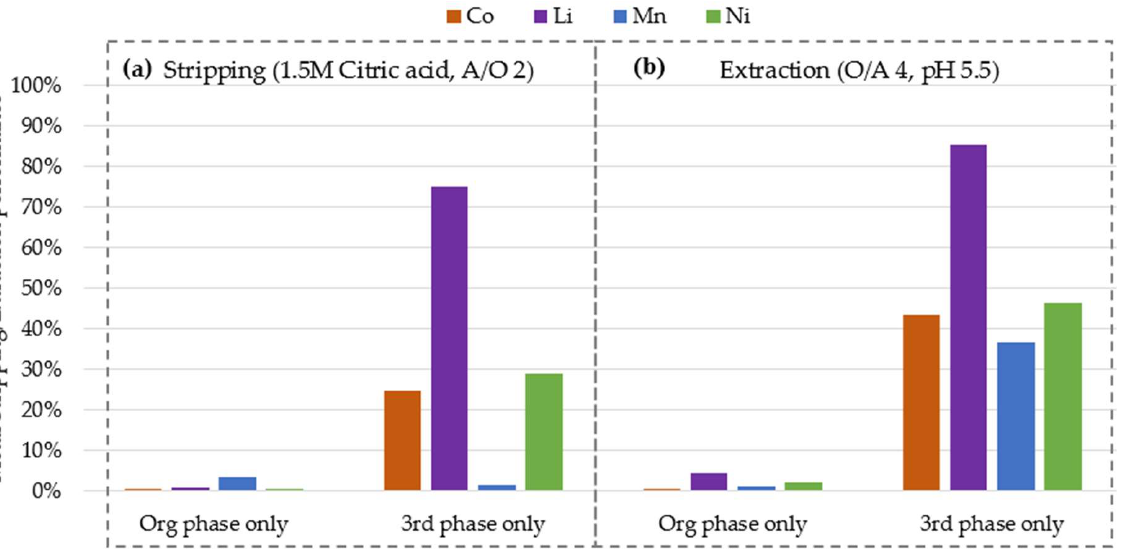
Figure 9. ( a ) Metals stripped from the organic and third phases and ( b ) extraction efficiency of each phase.